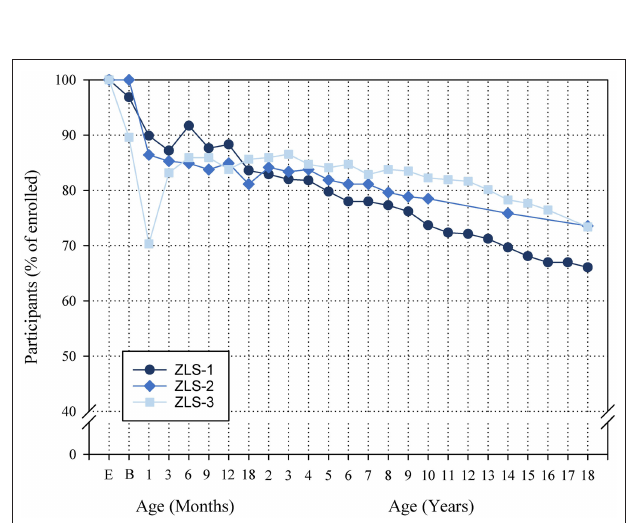
FIGURE 3 | Overview of the number of individuals enrolled in the three ZLS cohorts and the participation rate over the course of the studies. Semi-annual assessments and assessments after 18 years of age in the ZLS-1 cohort are not shown. In the process of digitizing the ZLS-Childhood archives, minor adaptations of these numbers may be necessary if further information on study participants becomes available. E, Enrollment; B, Birth.